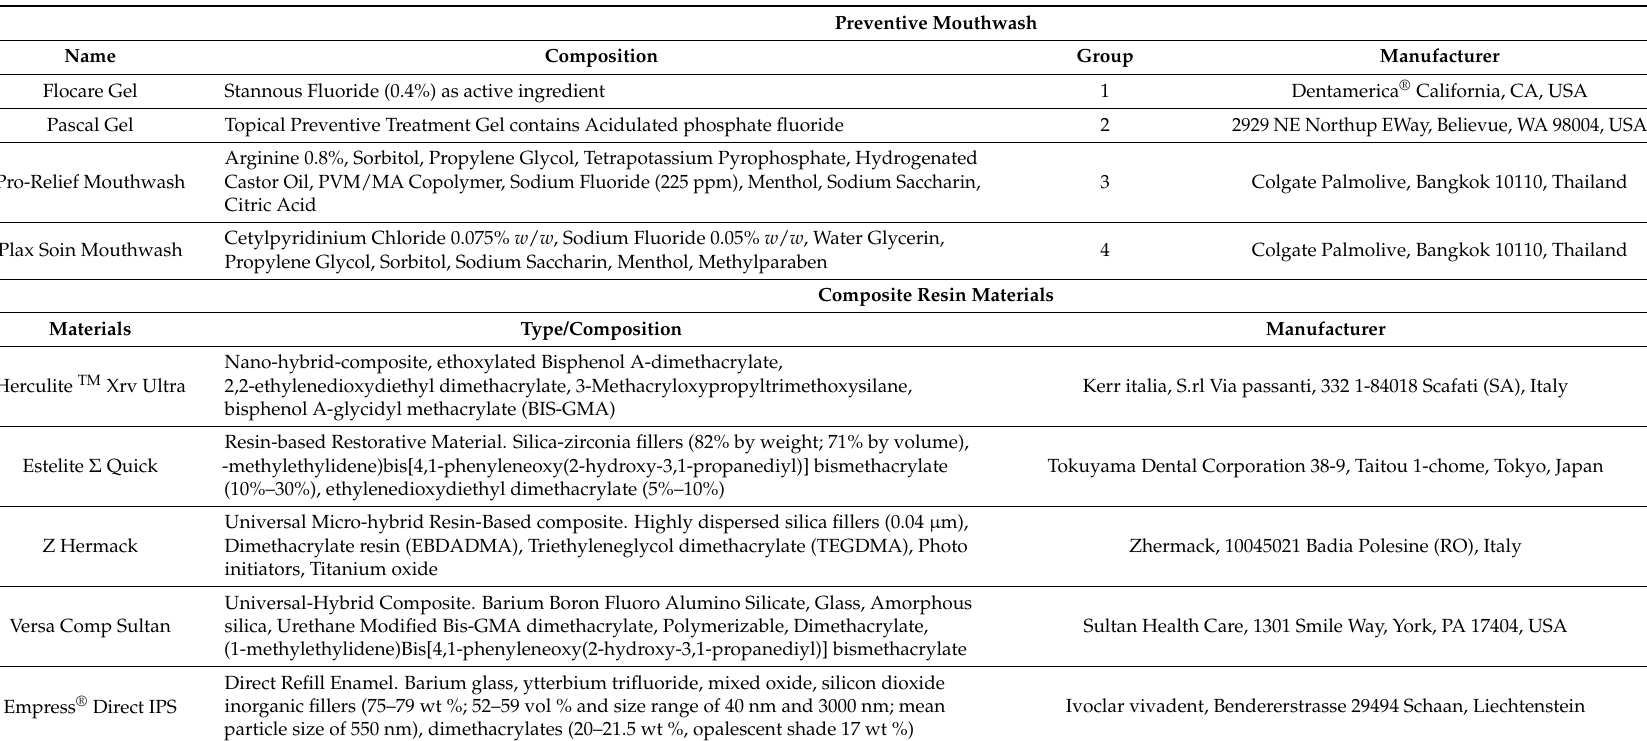
Table 2. Details of composite resin materials and preventive mouthwash used in this